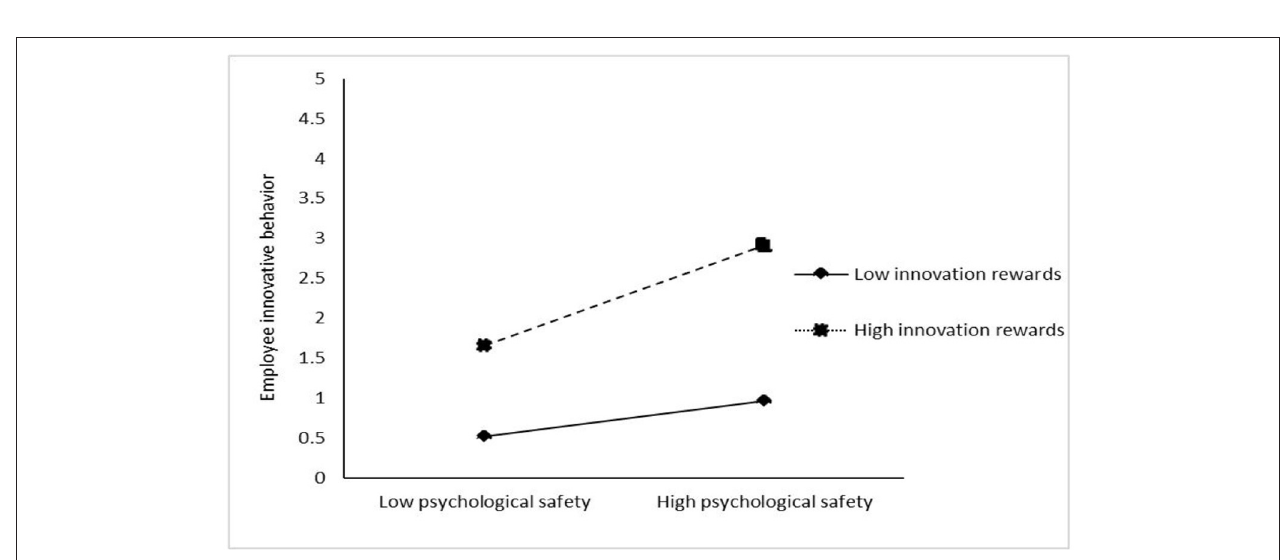
FIGURE 3 | Moderating effect of innovation rewards on the relationship of inclusive leadership and employee innovative behavior.